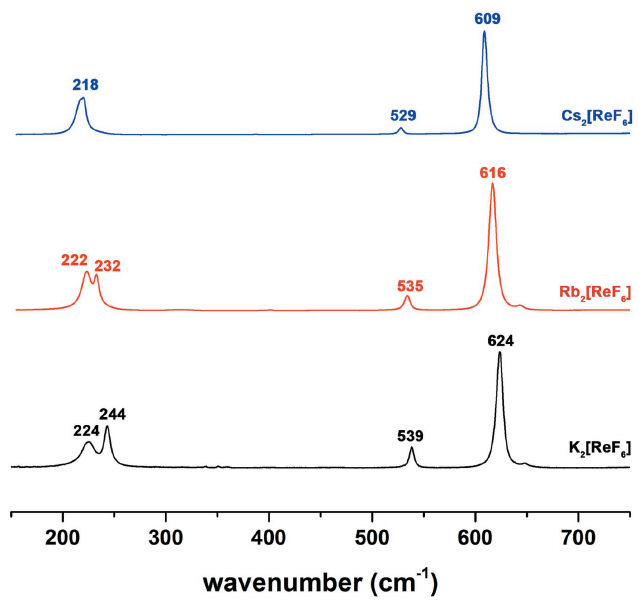
Figure 3 Raman spectra of A 2 [ReF 6 ] ( A = K, Rb, Cs).